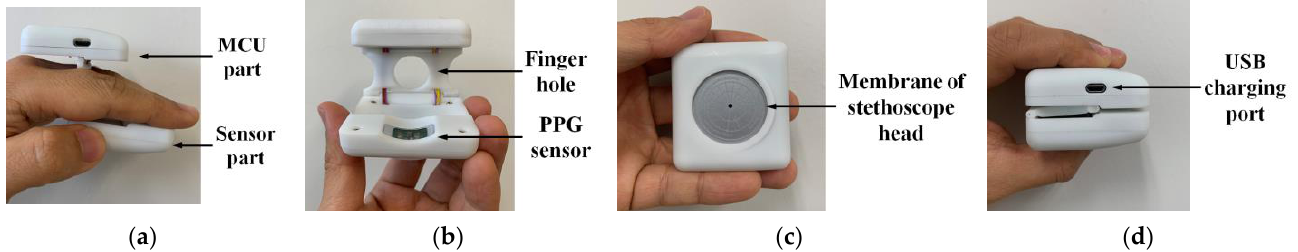
Figure 8. Picture of assembled finger-ring-shaped smart stethoscope prototype: ( a ) side view in user mode; ( b ) front view in user mode; ( c ) bottom view in user mode; ( d ) side view in collapsed mode.